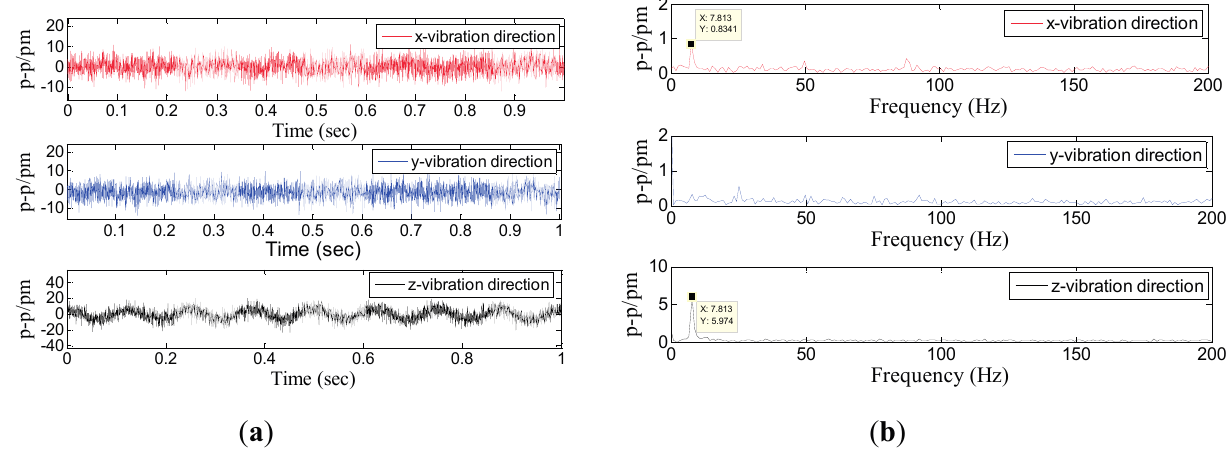
Figure 13. Response of the three directions under z -direction excitation with the acceleration — 1 m/s 2 -8 Hz. ( a ) Time domain response map. ( b ) Spectrum